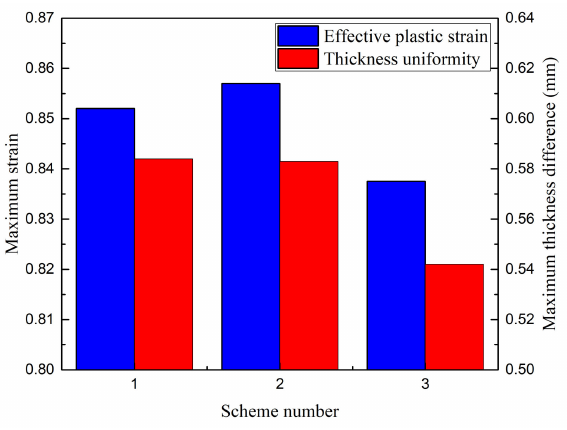
Figure 13. E ff ect of the number of forming passes.